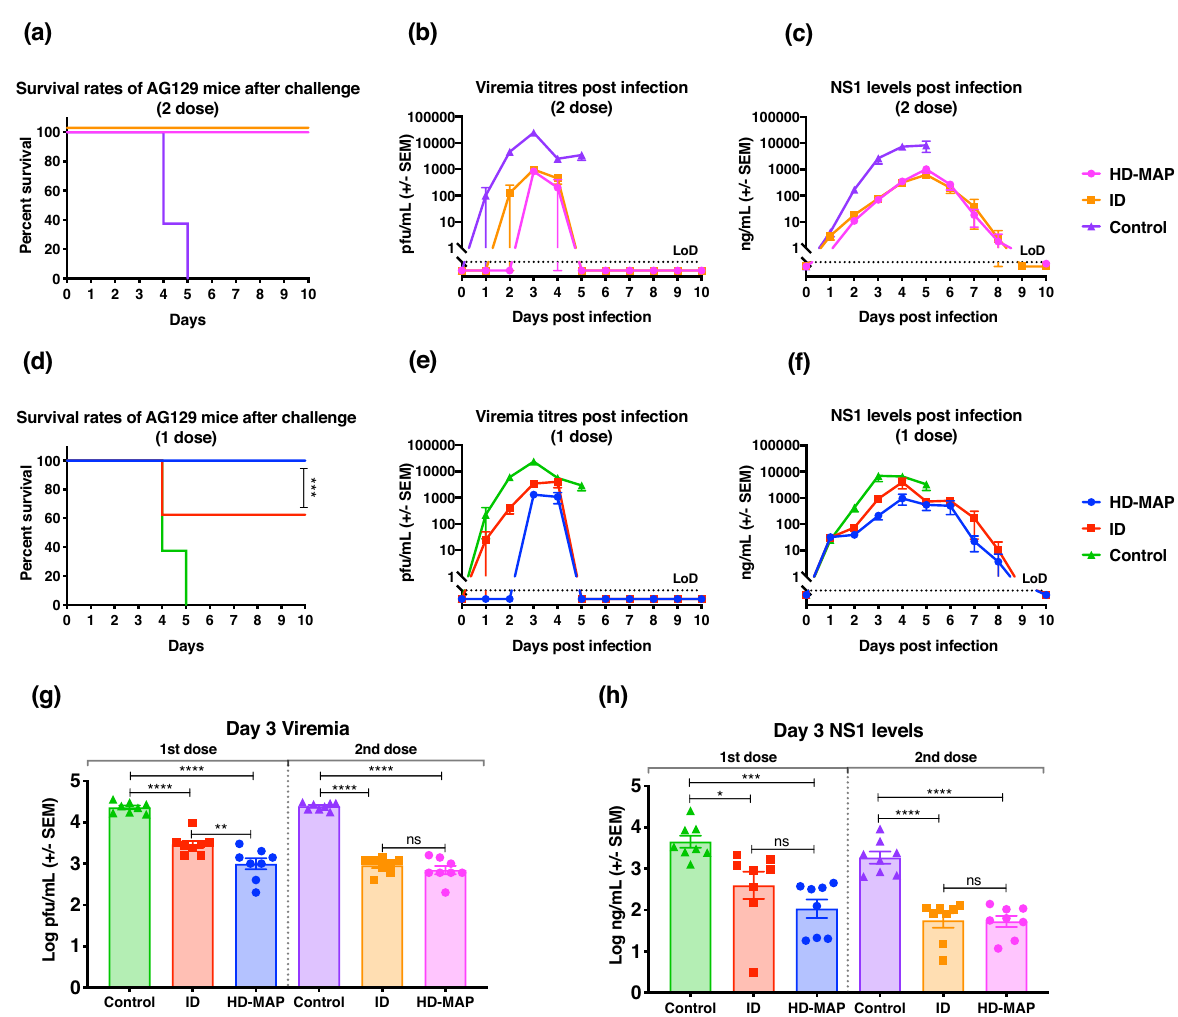
Fig. 6 Survival, viremia and NS1 secretion following BinJ/DENV2-prME immunization. a , d Survival rates of mice over 10 days post challenge. b , e Mean viremias were determined by plaque assay on Vero cells. Limit of detection was 50 pfu/mL. c , f Serum levels of NS1 were determined using quantitative capture ELISA. To demonstrate the signi fi cant differences between g viremia and h NS1 levels, data from day 3 post virus challenge were plotted. Each symbol represents a single mouse. Lines indicates mean antibody titres with bars showing ±SEM. **** p ≤ 0.0001, *** p ≤ 0.0003, ** p ≤ 0.002, * p ≤ 0.03 assessed by one-way analysis of variance (ANOVA, α -level IgG titres after a single dose compared to the ID vaccinated mice (Fig. 5b, p = 0.0005). An increase in IgG levels was observed after the second dose for both ID and HD-MAP groups, with higher antibody titres induced in the HD-MAP-vaccinated group (Fig. 5b, p = 0.01). To con fi rm the anti-DENV IgG from vaccinated animals antibody titres re fl ected vaccine-speci fi c IgG responses with mice vaccinated with a single dose via the HD-MAP having signi fi cantly